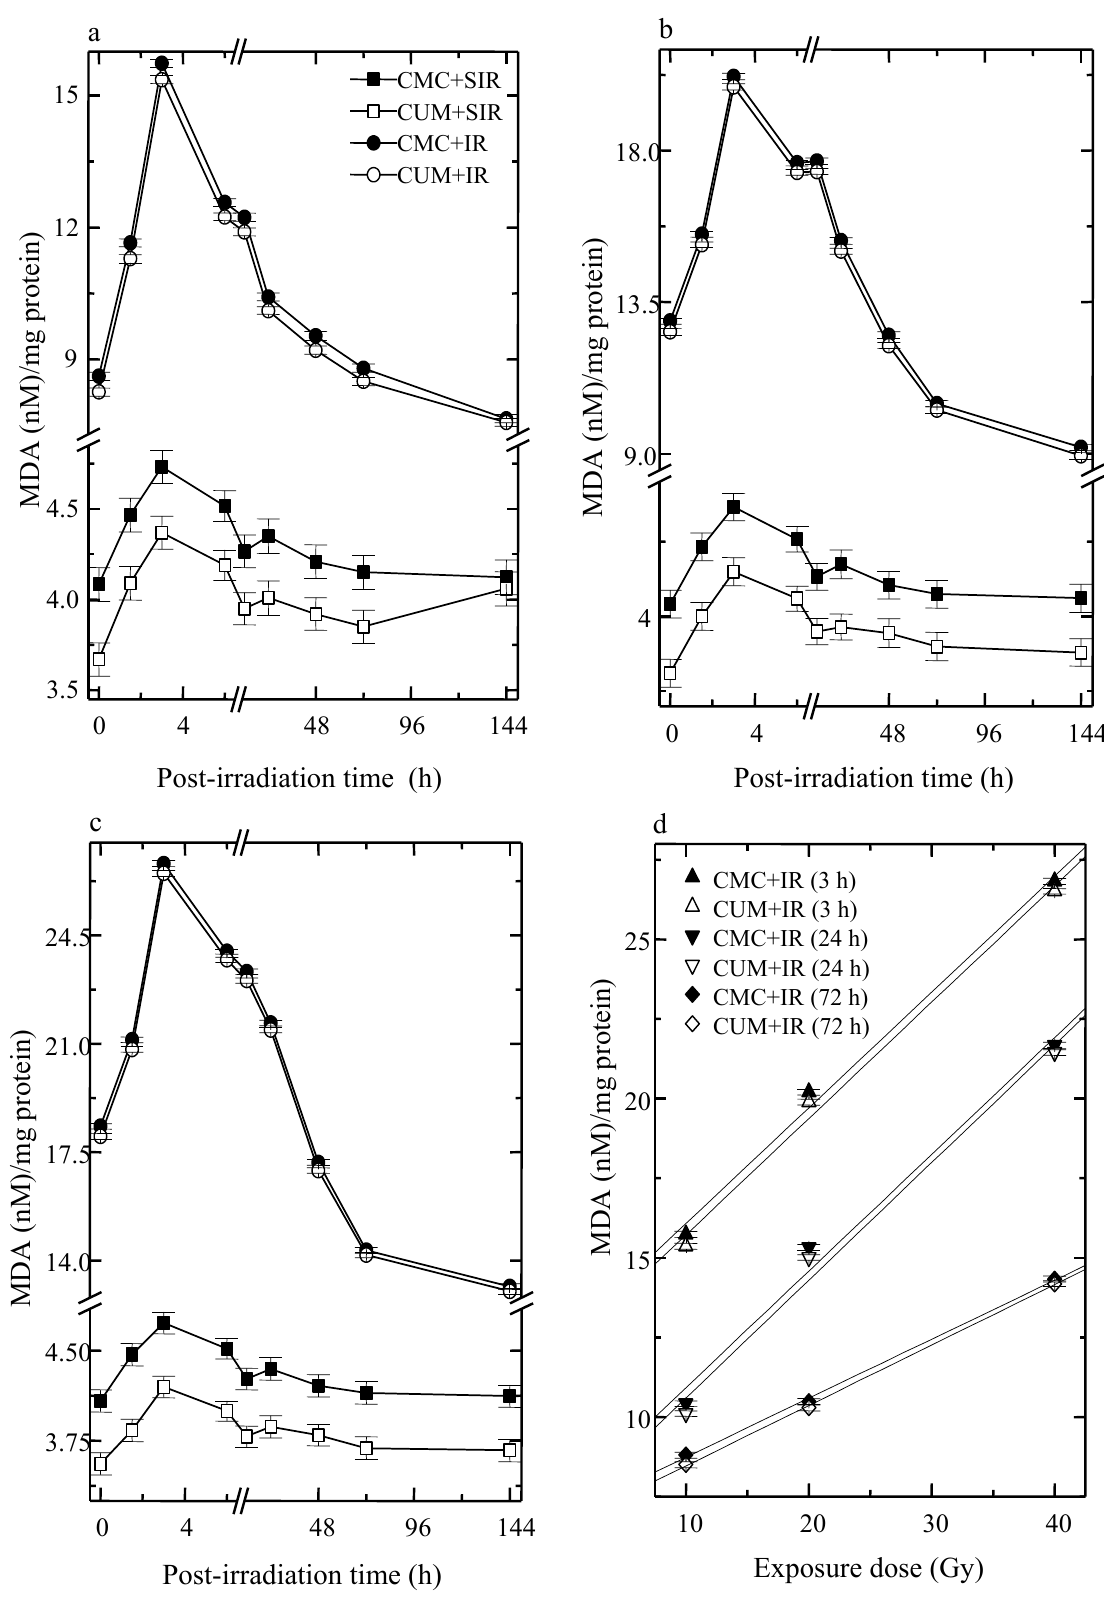
Figure 4. Effect of curcumin on lipid peroxidation level in the skin of mice exposed to fractionated doses of γ-radiation. ( a ) 10 Gy ( b ) 20 Gy ( c ) 40 Gy and ( d ) dose response